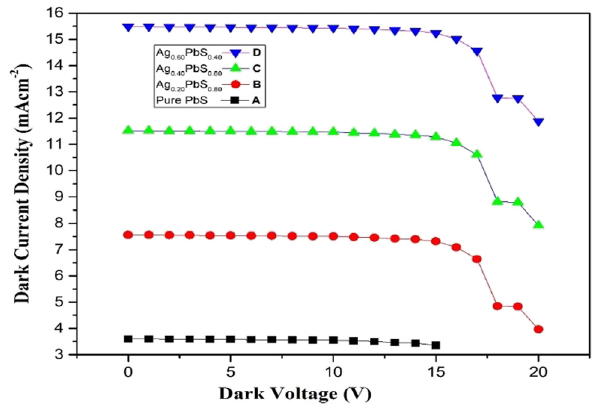
Figure 5: Dark current for pure PbS and Ag:PbS at di ff erent con - centrations: ( a ) 20%, ( b ) 40%, and ( c )